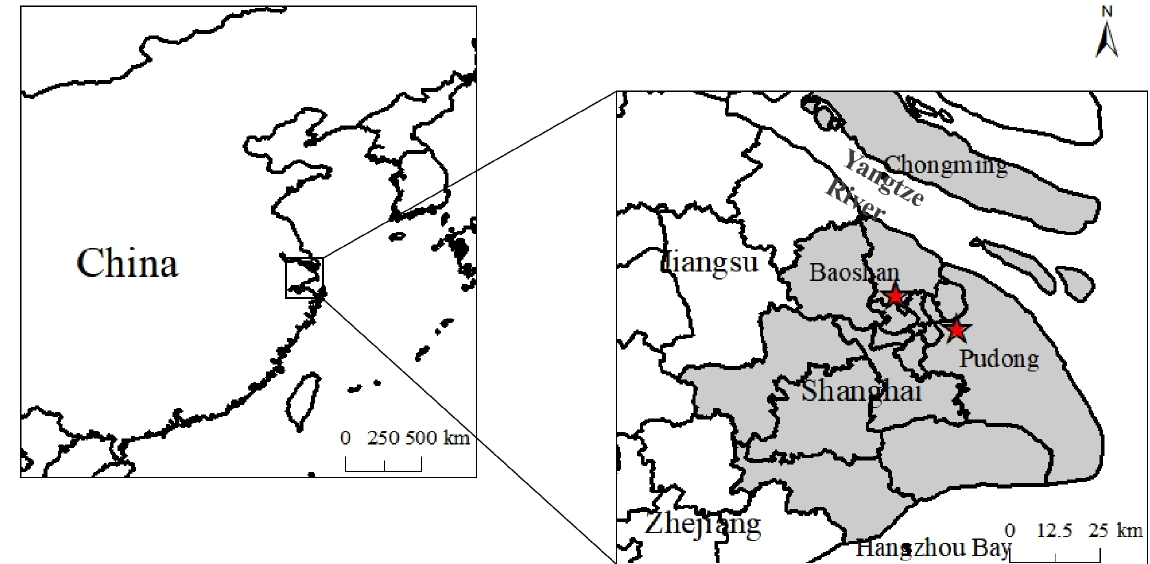
Figure 1. Map of the two sampling sites, BS and PD (red stars).